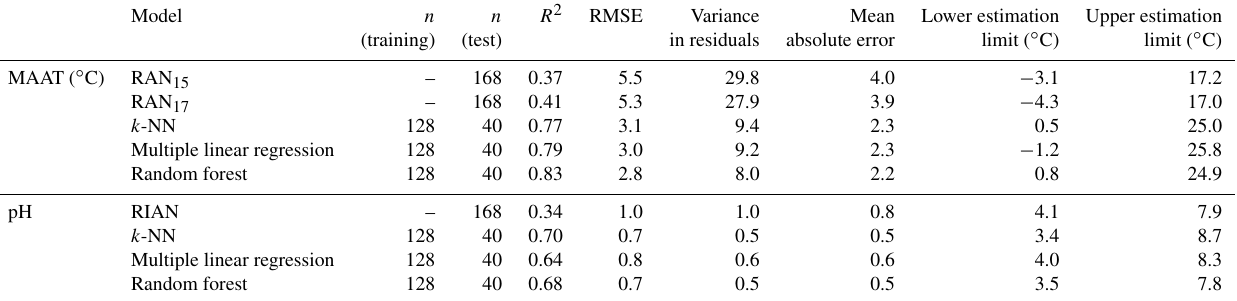
Table 2. Characteristics of the different models proposed in this study to estimate MAAT and pH: R 2 , RMSE, variance in the residuals, mean absolute error (MAE), and the upper and lower limits of estimation. The “training” samples were used to develop the different machine learning models, which were then tested on a “test” sample